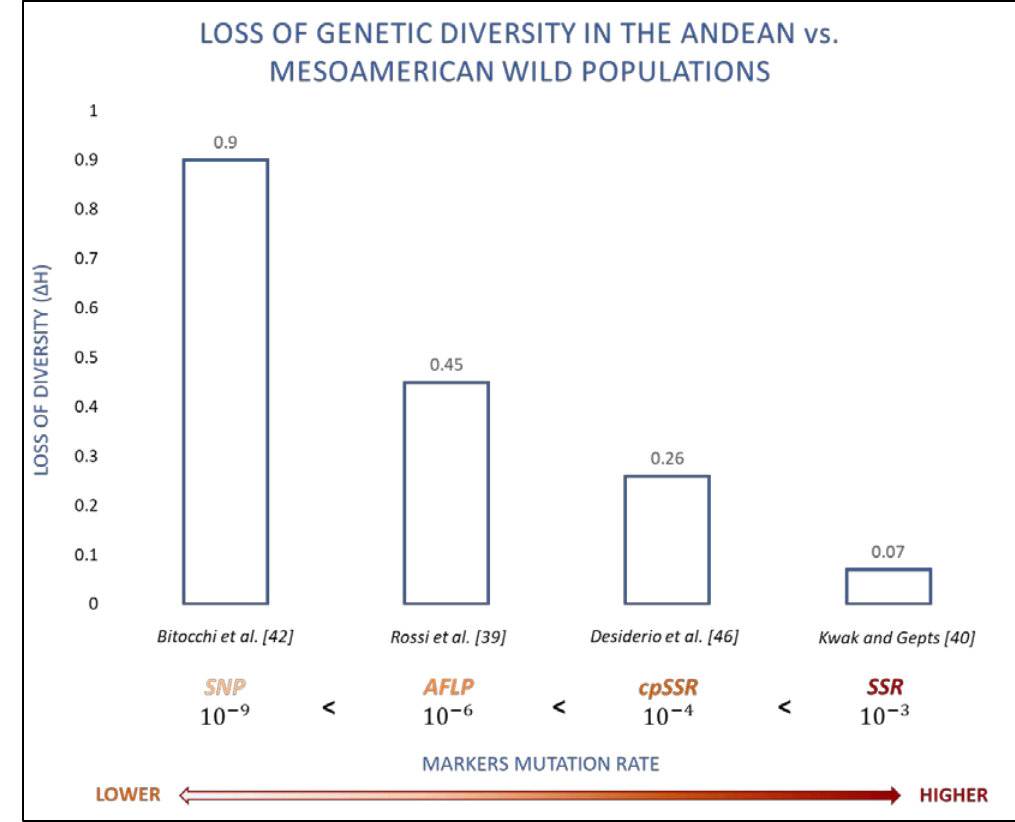
Figure 1. Loss of genetic diversity in the Andean versus Mesoamerican wild populations in the light of different molecular markers. SNP: single nucleotide polymorphisms, AFLP: amplified fragment length polymorphisms, cpSSR: chloroplast simple sequence repeats and SSR: simple sequence repeats.